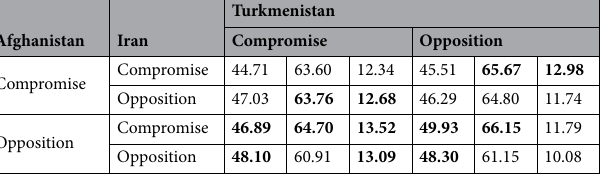
Table 3. Country payoff matrix corresponding to the countries’ strategies (annual revenue M$ = 10 6 $). Significance values are given in